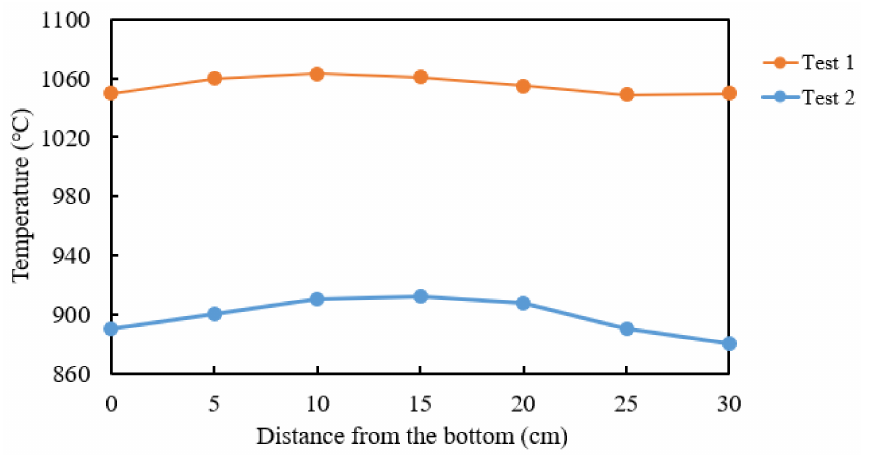
Figure 2. Temperature distribution in the